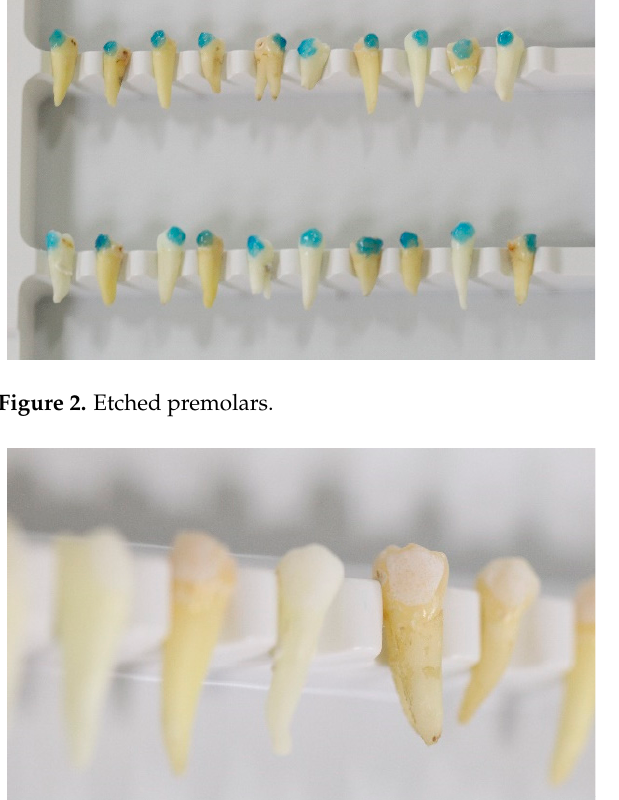
Figure 4. Teeth with bonded brackets in artificial saliva.